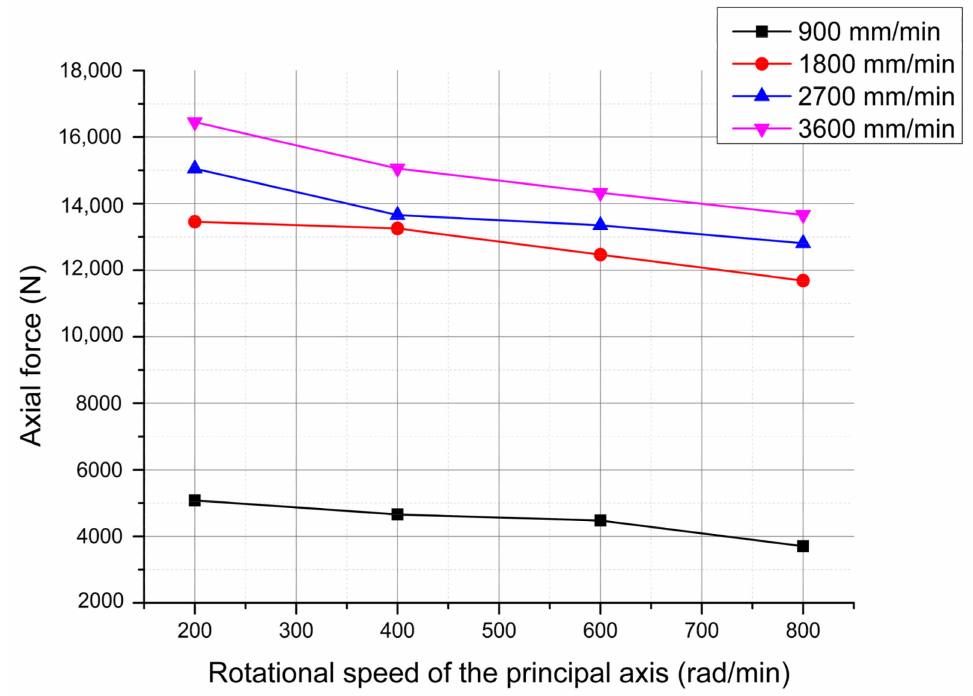
Figure 4. Average axial force at different rotational